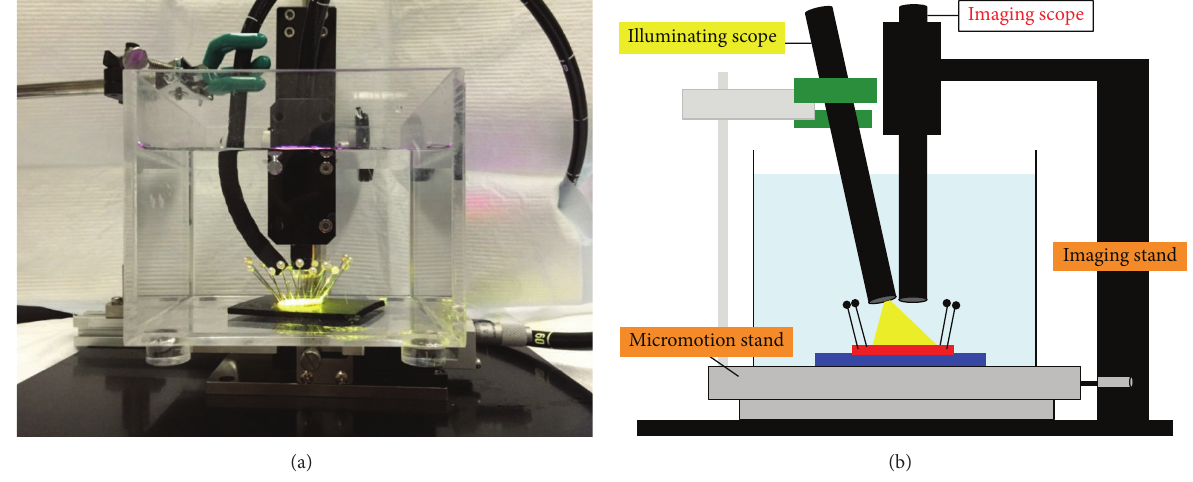
Figure 1: (a) The method of endoscopic imaging. (b) The simplified schematic of (a).